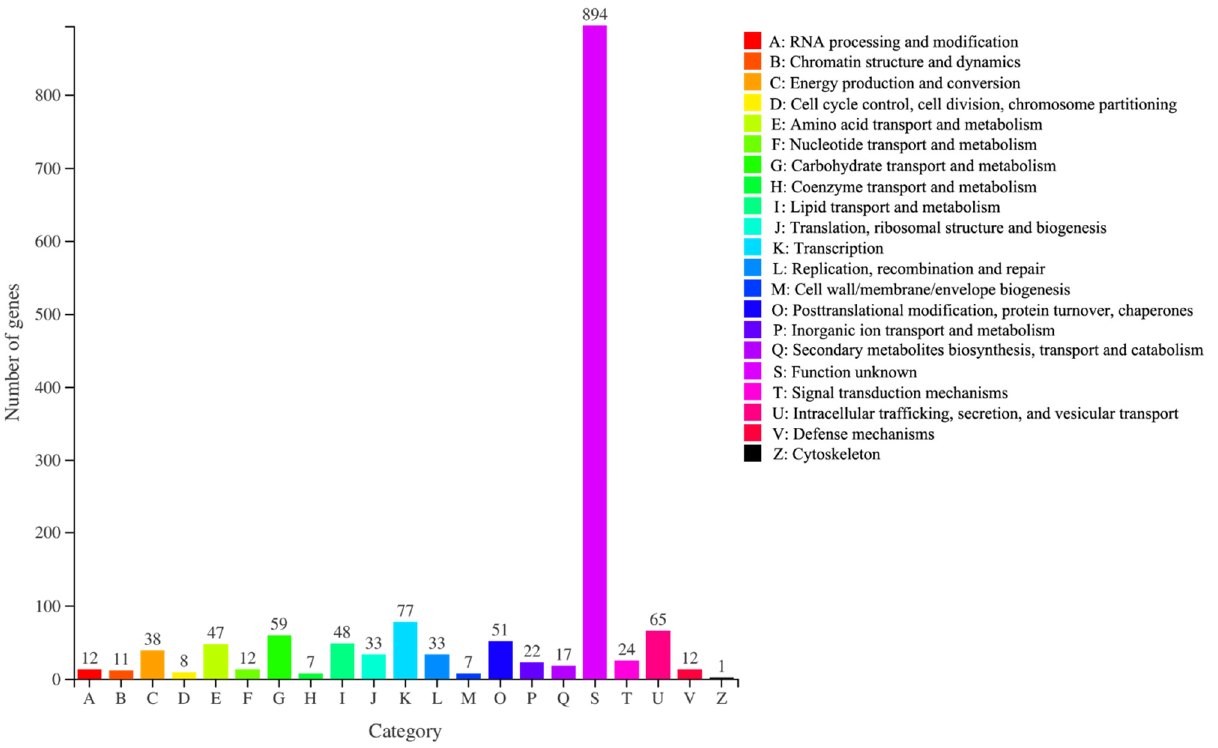
Figure 6. COG functional classification of DEGs in “Con vs T11”.